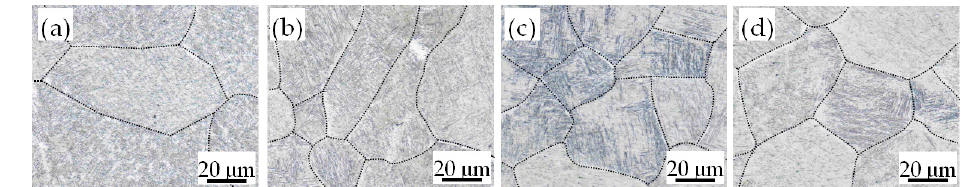
8 of 15 Figure 10. Microstructure of laser–TIG hybrid welded joints with different currents: ( a ) I = 30 A, arc zone; ( b ) I = 30 A, laser zone; ( c ) I = 30 A, HAZ; ( d ) I = 50 A, arc zone; ( e ) I = 50 A, laser zone; ( f ) I = 50 A, HAZ. Figure 11 shows the microstructure of the arc zone with different currents. In order to clearly observe the grain size of TC4 titanium alloy in the arc zone of laser–TIG hybrid welding, the grain boundaries in the picture are marked with dotted lines. It can be seen